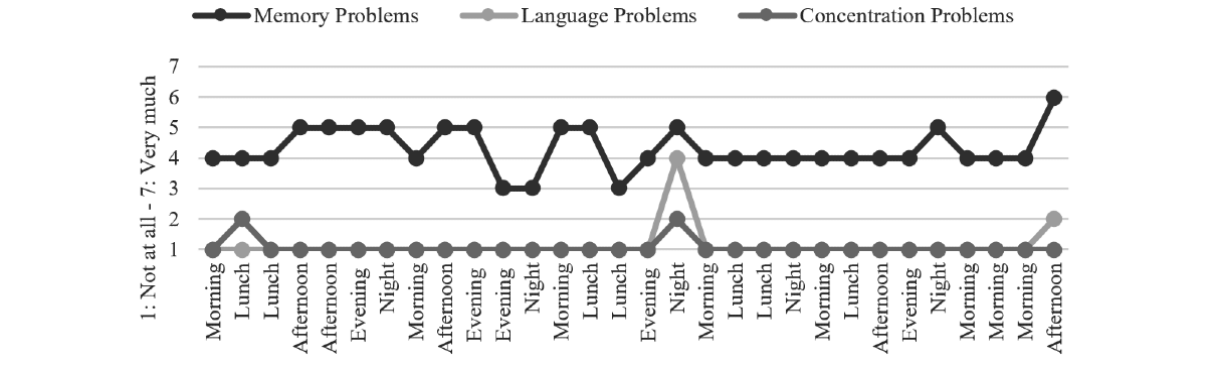
Figure 2. Person 1: subjectively experienced cognitive problems.